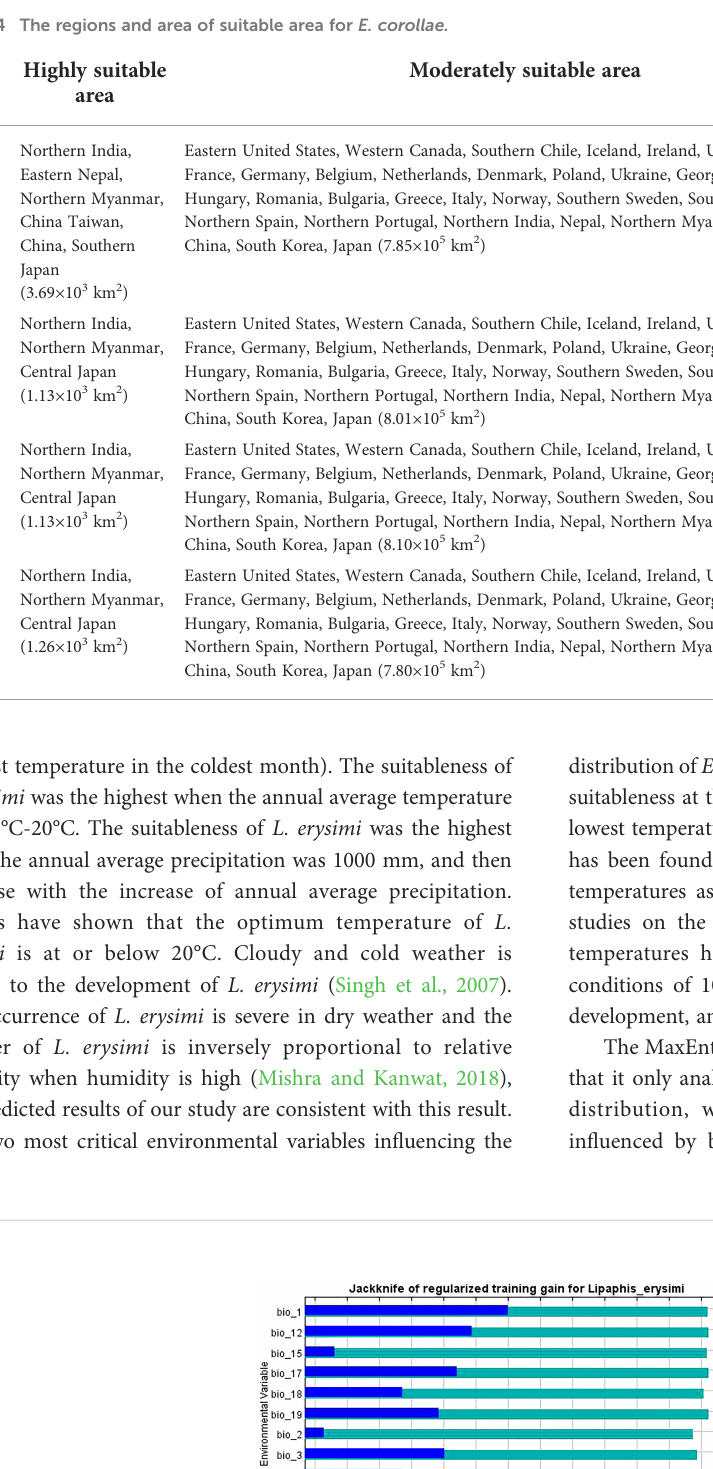
TABLE 4 The regions and area of suitable area for E. corollae.